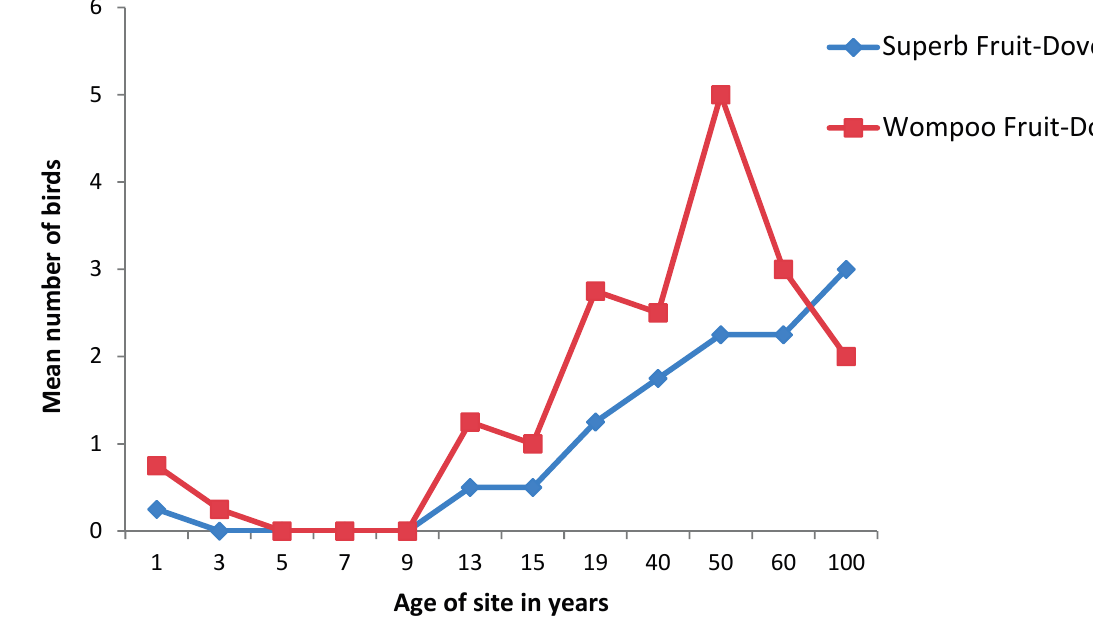
Figure 1. Average counts (n = 4) of two species of fruit-doves in different aged planted sites up to 19 years old and older reference sites, Barron River. Unpublished data from Kuranda